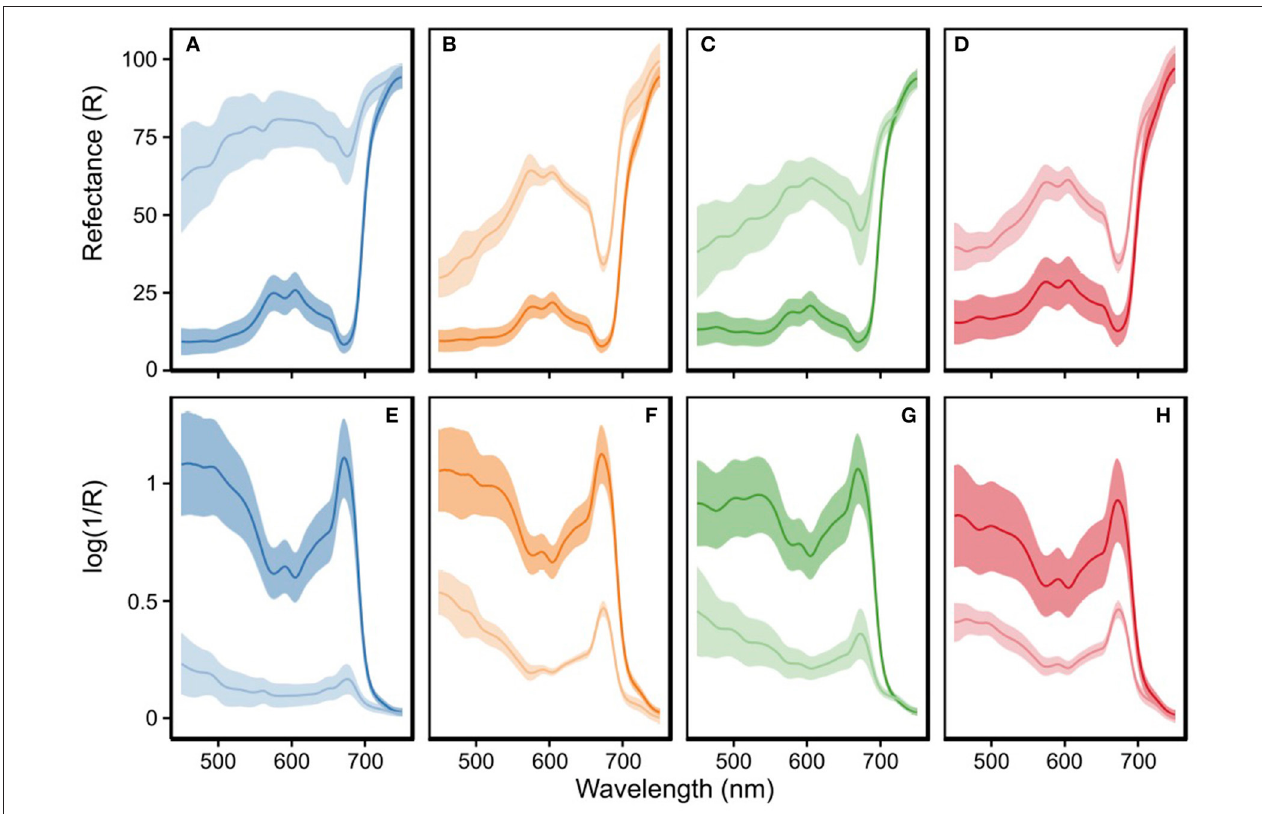
FIGURE 2 | Spectroscopic determinations for Orbicella annularis (blue), Orbicella faveolata (orange), Montastraea cavernosa (green), and Pseudodiploria strigosa (red) for unstressed (dark color) and stressed/bleached (light color) coral samples: (A–D) reflectance spectra and (E-H) calculated absorbance (D) spectra from reflectance (R) measurements as log(1/R), according to Shibata (1969). Shading colored area represents the standard deviation (STD) variability for > 90 determinations for unstressed samples of O. annularis ( n = 123), O. faveolata ( n = 96), M. cavernosa ( n = 110), and P. strigosa ( n = 194); and n > 10 for stressed/bleached samples of O. annularis ( n = 122), O. faveolata ( n = 13), M. cavernosa ( n = 28), and P. strigosa ( n = 54). Unstressed samples represent a subset of the 28 ◦ C treatment of all experiments, while for the stressed/bleached group data describe all samples